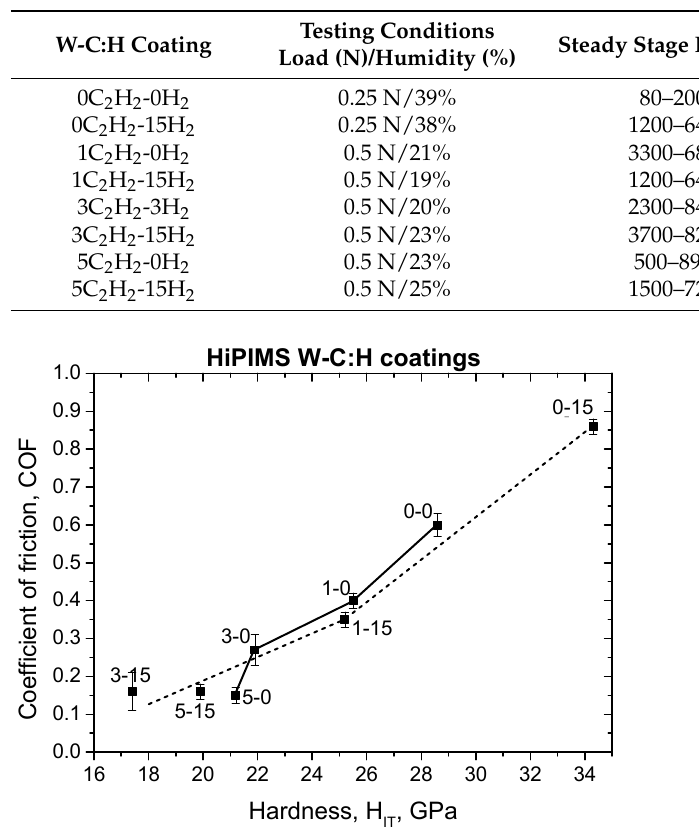
Table 2. Summary of the steady coefficients of friction in HiPIMS W-C:H coatings obtained during friction in humid air.